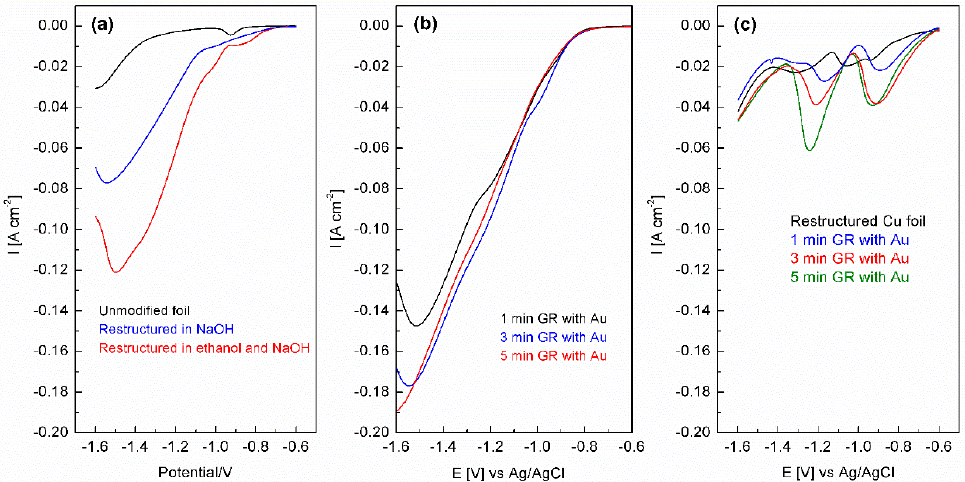
Figure 6. Linear sweep voltammograms recorded at 100 mV s − 1 in 1 M NaOH in the presence of